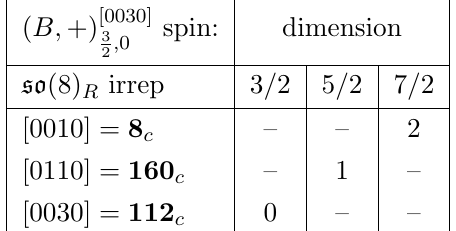
Table 11 . All possible conformal primaries in S 2 (cid:2) S 3 corresponding to the ( B; +) [0030] formal multiplet.